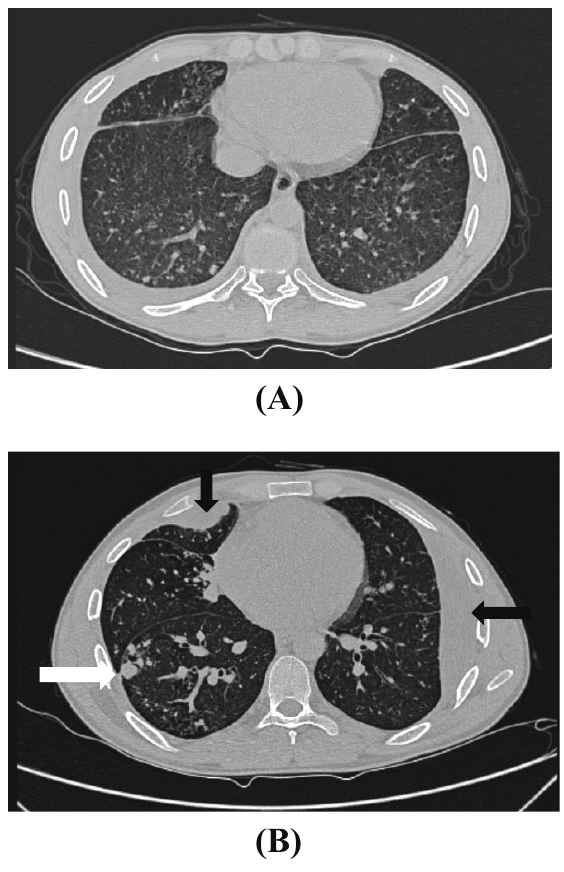
Figure 4 : (A) Axial section of HRCT lung in a case of tuberculosis before treatment shows no significant parenchymal findings. (B) Posttreatment HRCT scan shows pleural collection/empyema (black arrow) along the right anterior and left lateral chest wall with ill-defined nodules (white arrow) in right lower